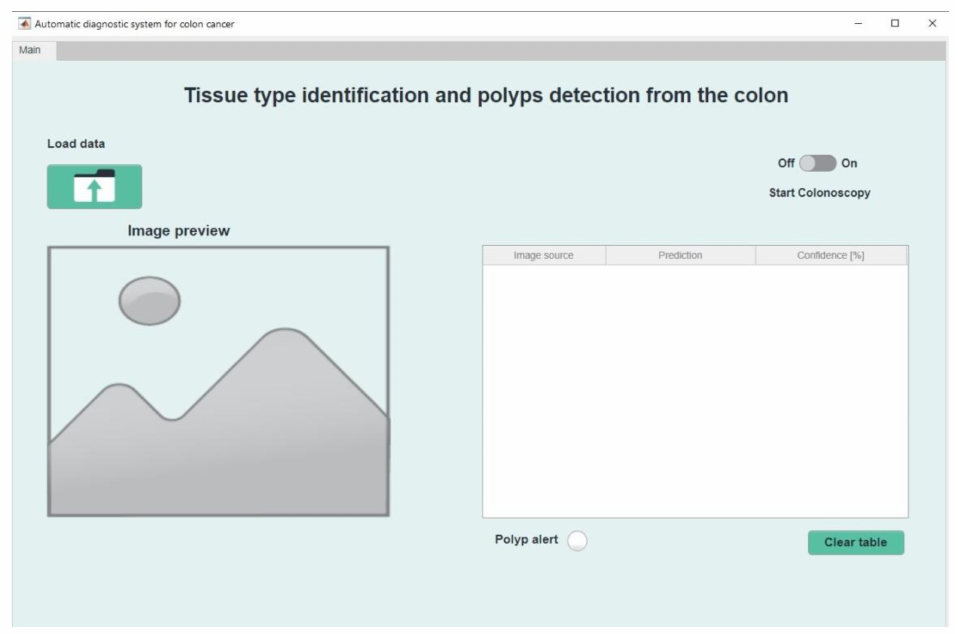
Figure 8. The main menu of the application.